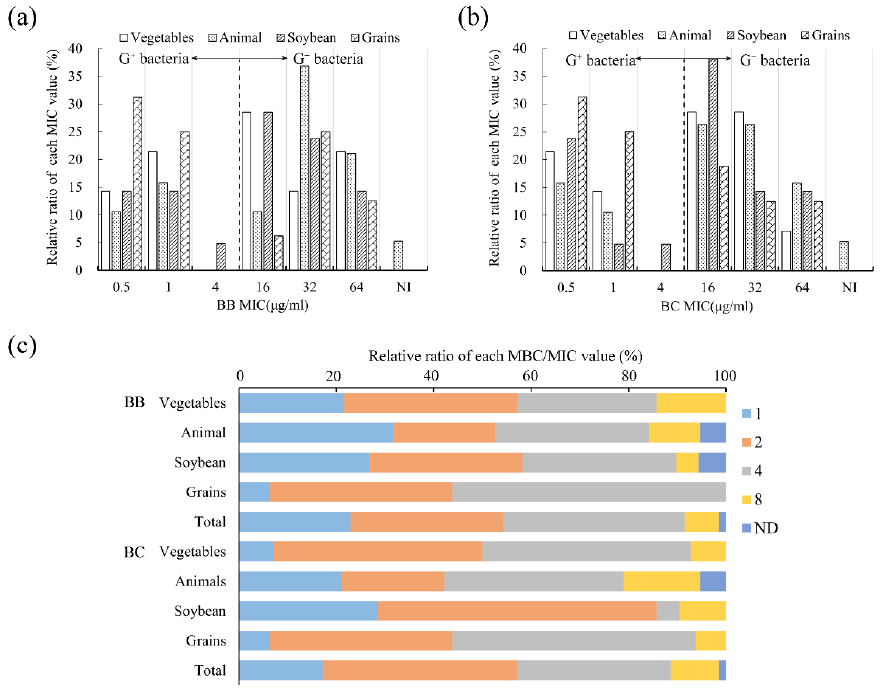
Figure 3. Antibacterial activity of brevilaterins against 70 strains of isolated spoilage bacteria. ( a , b ) the distribution of MIC values of brevilaterin B (BB) and brevilaterin C (BC) against all isolated spoilage bacteria. G + and G − stand for Gram-positive and Gram-negative, respectively, for convenience; ( c ) the relative ratio of MBC/MIC value of brevilaterins against spoilage bacteria from different foods. ND, no value for undetected MIC and MBC.